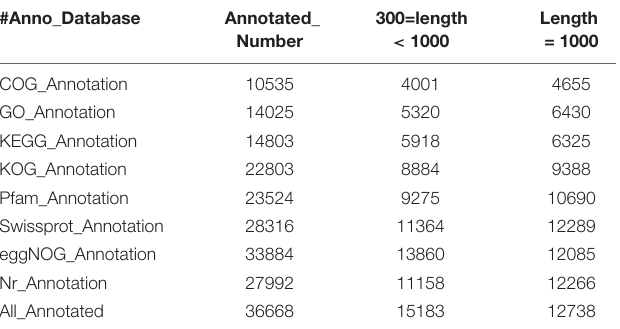
TABLE 3 | Statistics of the unigene